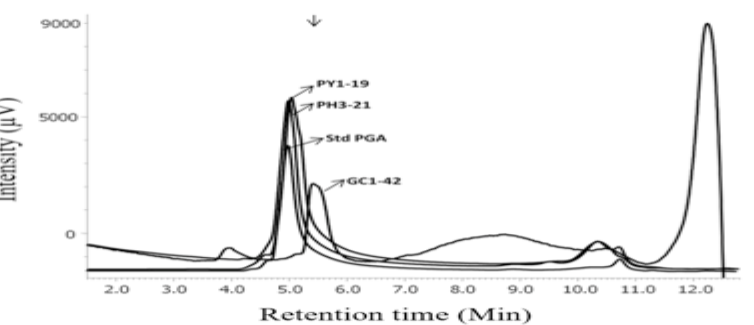
Figure 6. The relative molecular weight was determined in relation to elution of standard markers (indicated in arrows), thyroglobulin (mw = 660 kDa). The chromatograms of B. safensis subsp. safensis PY1-19 shows the highest peak of 78.9% of glutamic acid, followed by B. subtilis PH3-21 (72.3%) and the lowest by B. velezensis GC1-42 (60.2%) along with standard PGA. The elution time for all other samples remained similar. Table 2. Amino acid contents of PGA extracted from Bacillus spp. of naturally fermented soybean